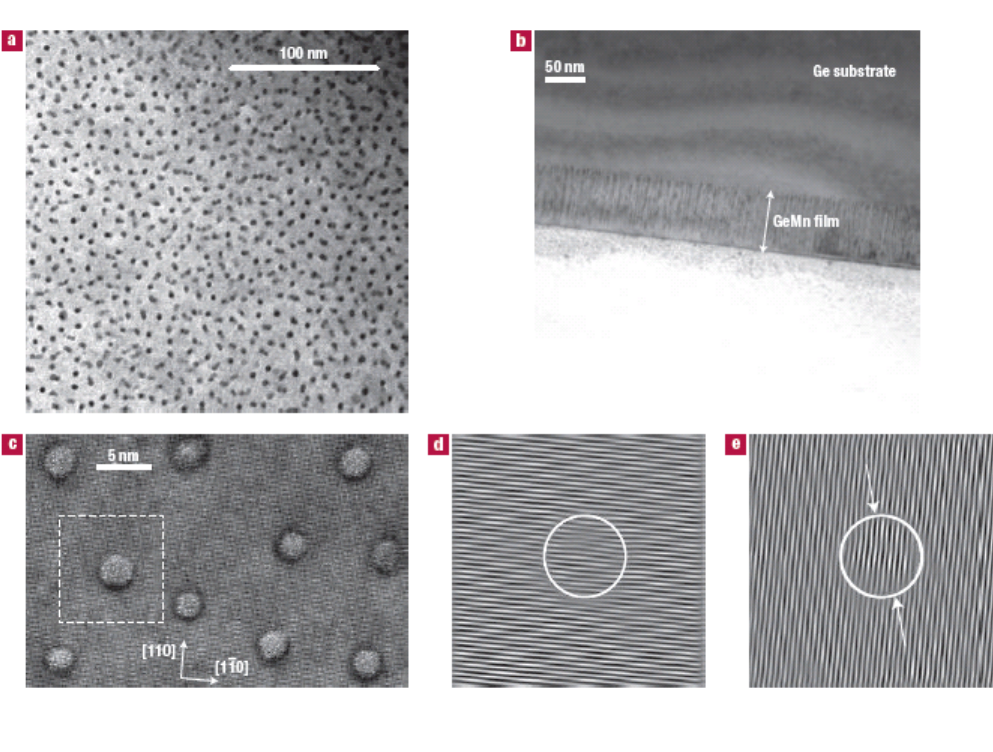
(a) Low-magnitude plane view, the dark spots are nanocolumns. (b) Low-magnitude cross-sectional image of the 80-nm-thick (Ge,Mn) layer, the nanocolumns are perpendicular to the film plane and appear as dark lines. (c) High-resolution plane view along [001] in the thinnest part of the sample. (d) and (e), Bragg filtering of (220) and (2 2 0) diffraction spots, respectively. The dashed square in (c) shows the selected area. The nanocolumn is surrounded by a white circle and the white arrows indicate the position of dislocations. A detailed explanation can be found in Ref. [23]. Reprinted by permission from Macmillan Publishers Ltd: Ref.